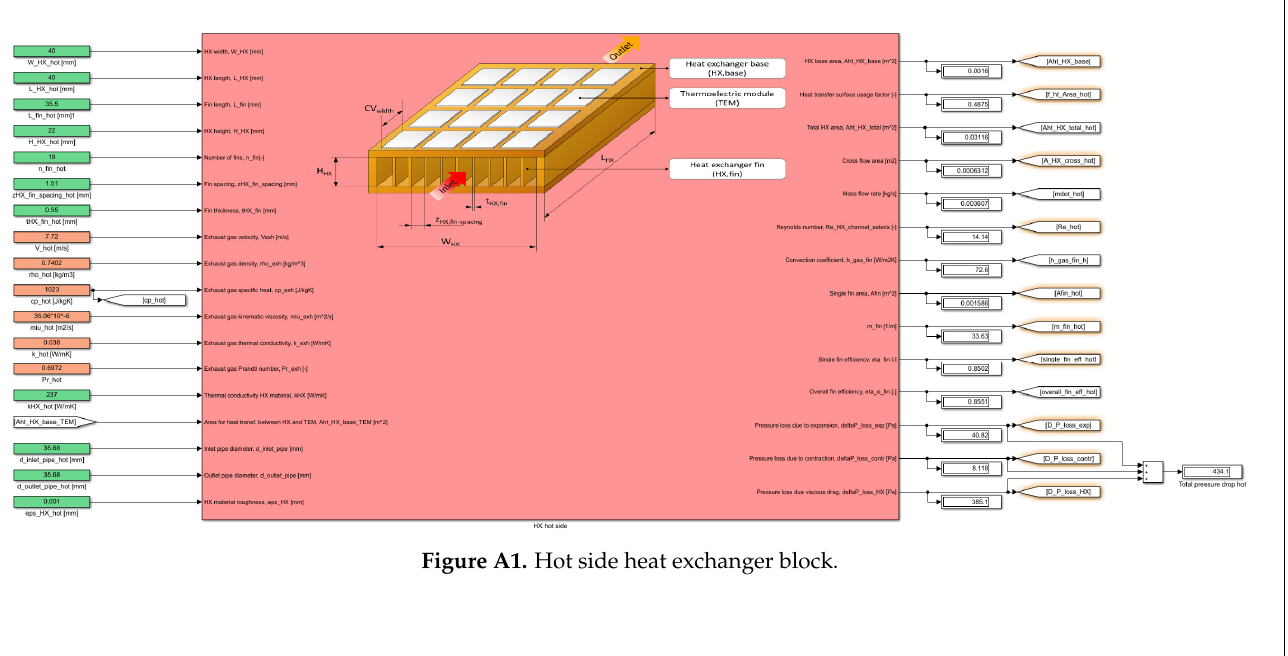
Figure A1. Hot side heat exchanger